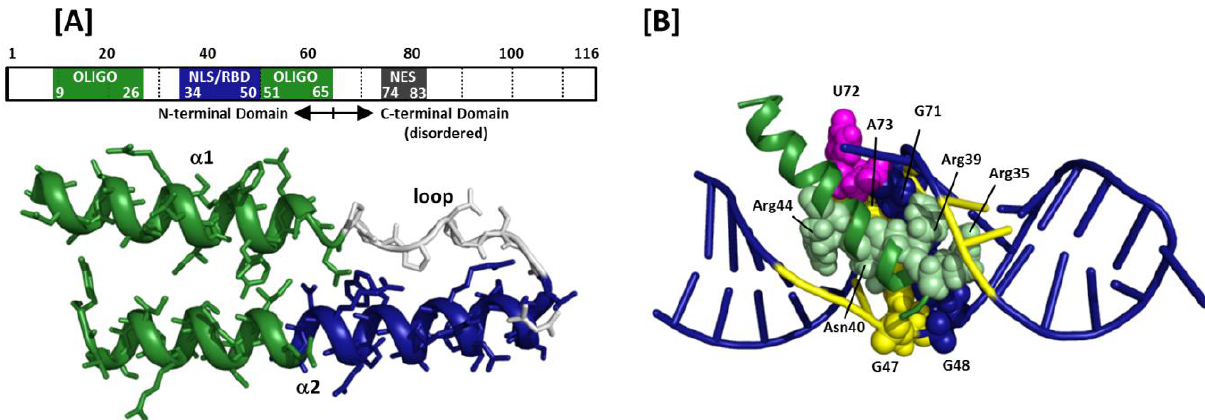
Figure 2. Rev structural organization and arginine-rich motif (ARM)/stem loop IIB complex: ( A ) Rev organization according to primary sequence and 3D structure. The